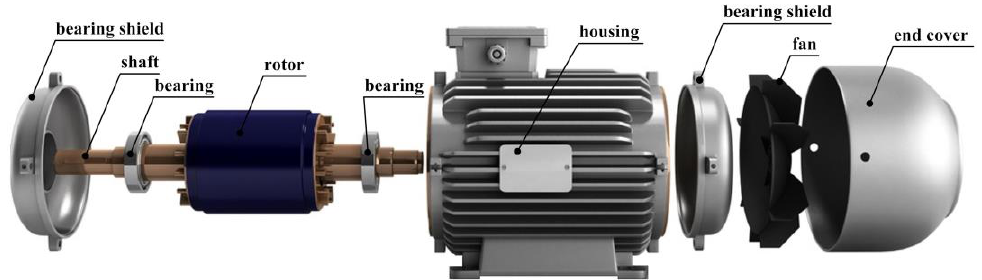
Figure 1. Typical AC induction